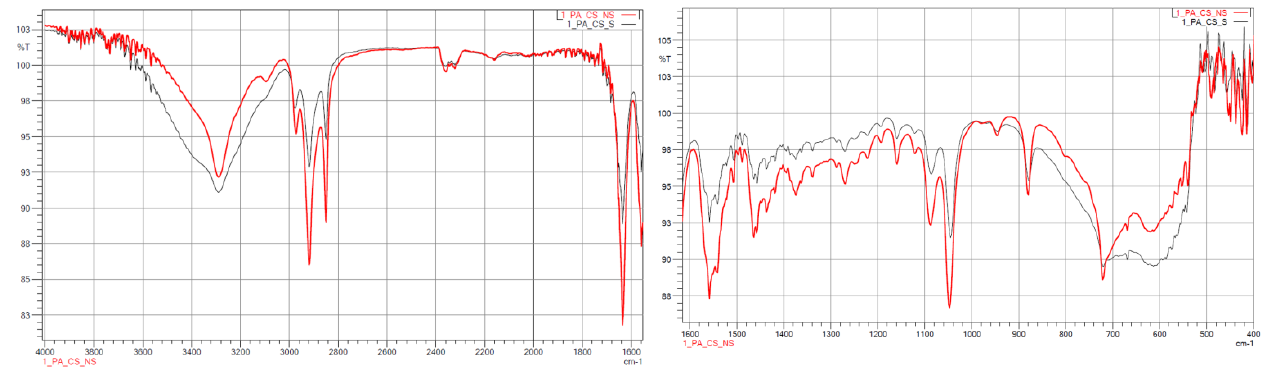
Figure 9. IR spectra for PA12_ Al 2 O 3 non ‐ sterilised (red curves) and sterilised (black curves) samples.